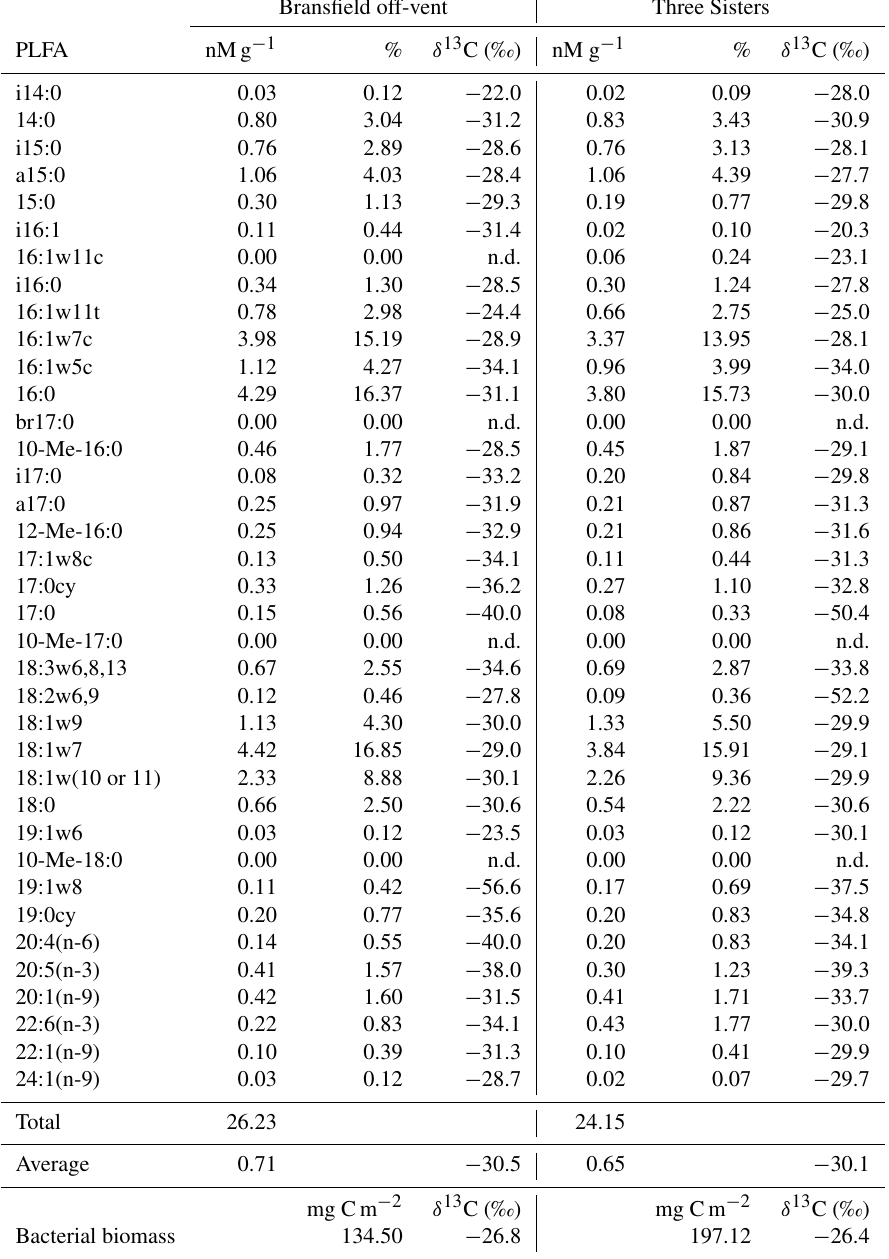
Table 4. PLFA profiles from freeze-dried sediment (nM per g dry sediment). PLFA names relate to standard notation (i: iso; a: anti-iso;